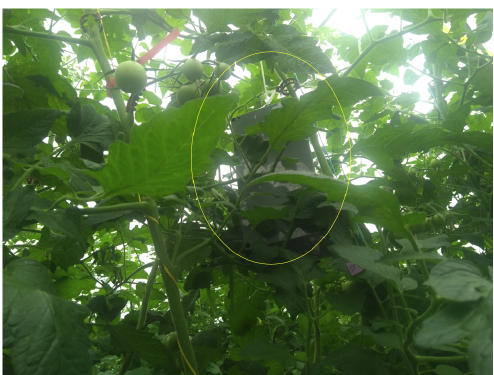
Figure 16. Sensors covered with plants can result in improper prediction due to the variation in